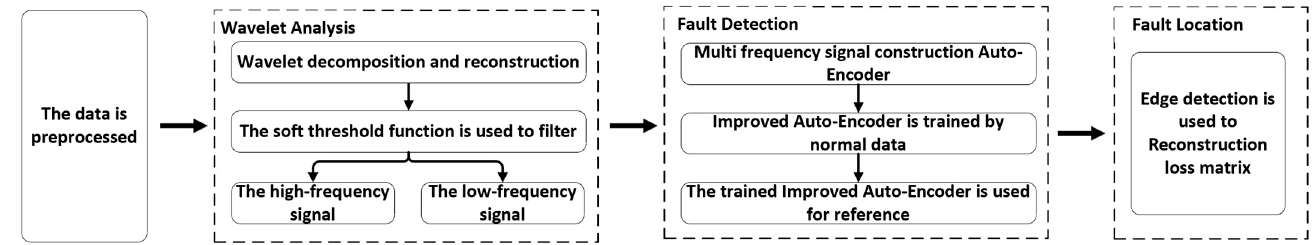
Figure 1. The methodological framework of this study.